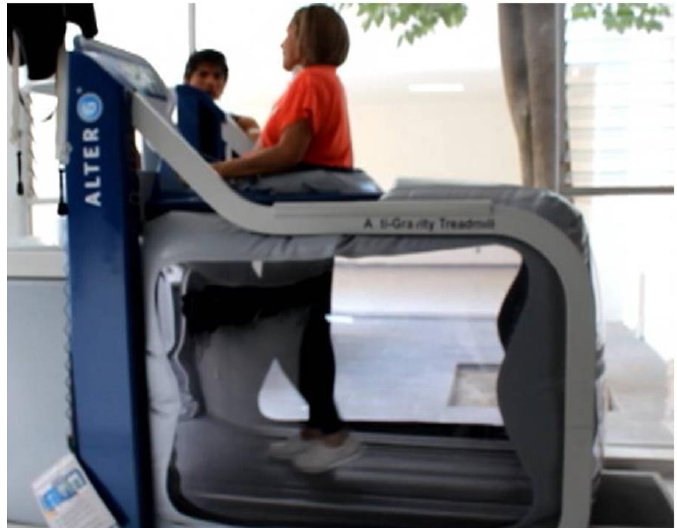
Figure 1. This picture shows the function of the antigravity treadmill (AlterG) which is based on positive air pressure in the lower extremities.